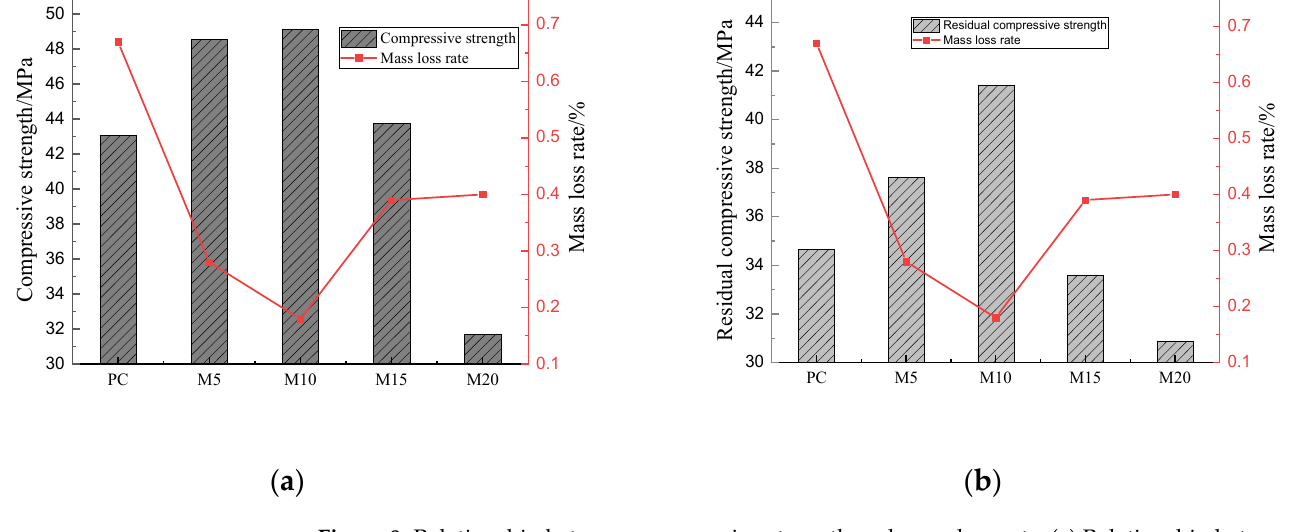
Figure 8. Relationship between compressive strength and mass loss rate; ( a ) Relationship between initial compressive strength and mass loss rate, ( b ) Relationship between residual strength and mass loss rate.